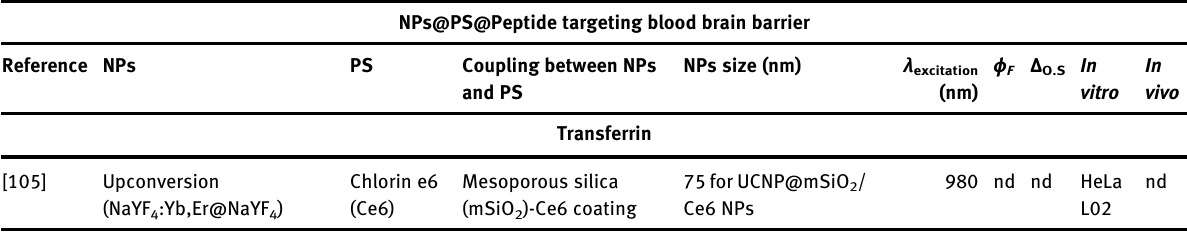
Table  : The summary of NPs conjugated with PSs and peptides targeting BBB in terms of different parameters.